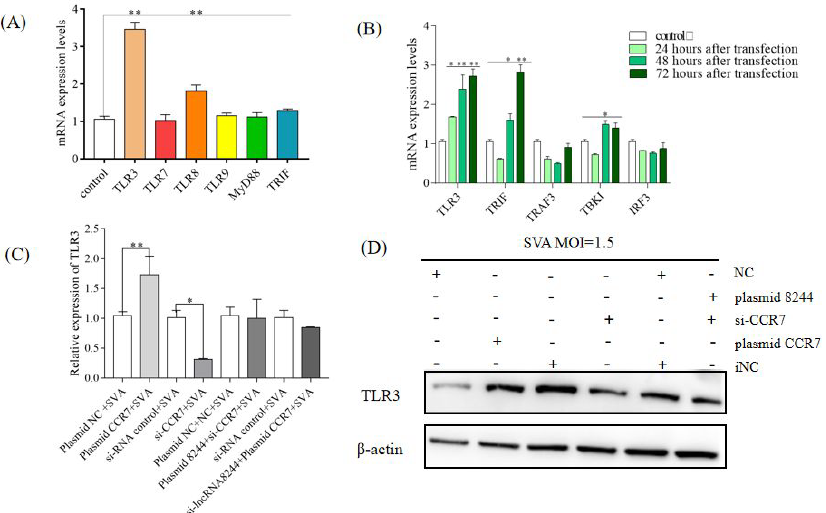
Figure 9. CCR7 can up-regulate the expression of key molecules in the TLR signaling pathway. ( A ) The expression level of TLR3 / TLR7 / TLR8 / TLR9 / MyD88 / TRIF. ( B ) The expression level of TLR3 / TRIF / TRAF3 / TBK1 and IRF3. ( C ) The expression level of TLR3 was normalized to the mRNA level of GAPDH, and anti- βactin was used as a control for Western blot sample loading ( D ). All data are represented as mean ± SD with three replicates. * p < 0.05; ** p < 0.01.